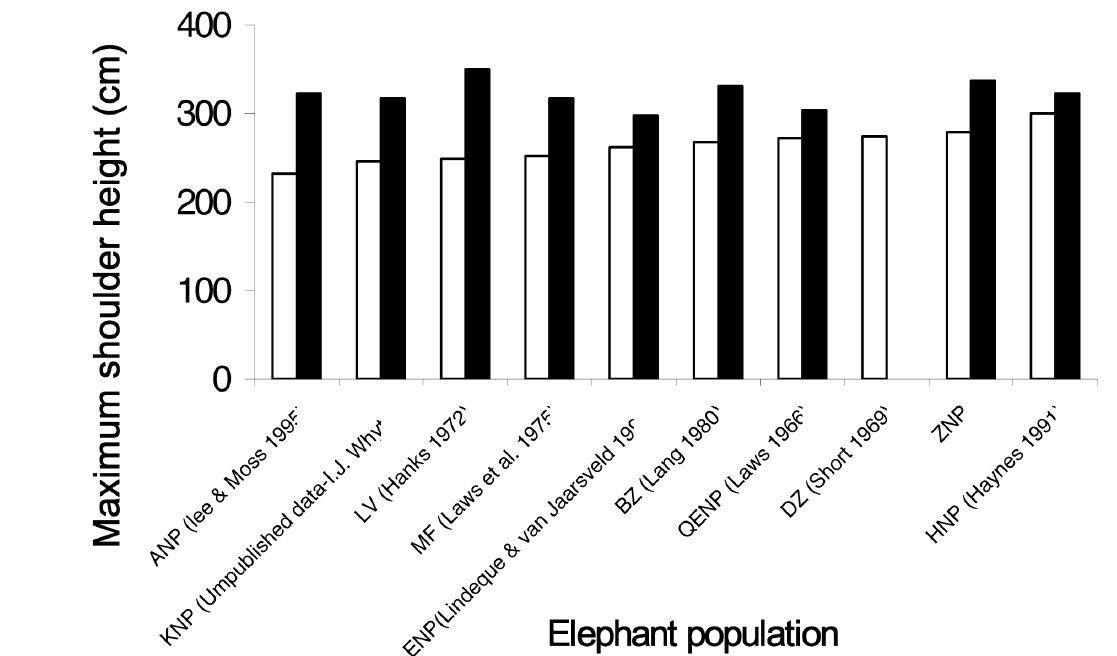
Fig. 6. Maximum shoulder height observed in different populations of African elephants. Numbers above the bars indicate the maxi- mum height values. Black bars represent males, and white bars represent the females. ANP = Amboseli National Park; KNP = Kruger National Park; LV = Luangwa Valley; MF = Murchinson Falls; ENP = Etosha National Park; BZ = Basle Zoo; QENP = Qeen Elisabeth National Park; DZ = Diksie Zoo; ZNP = Zakouma National Park; HNP = Hwange National